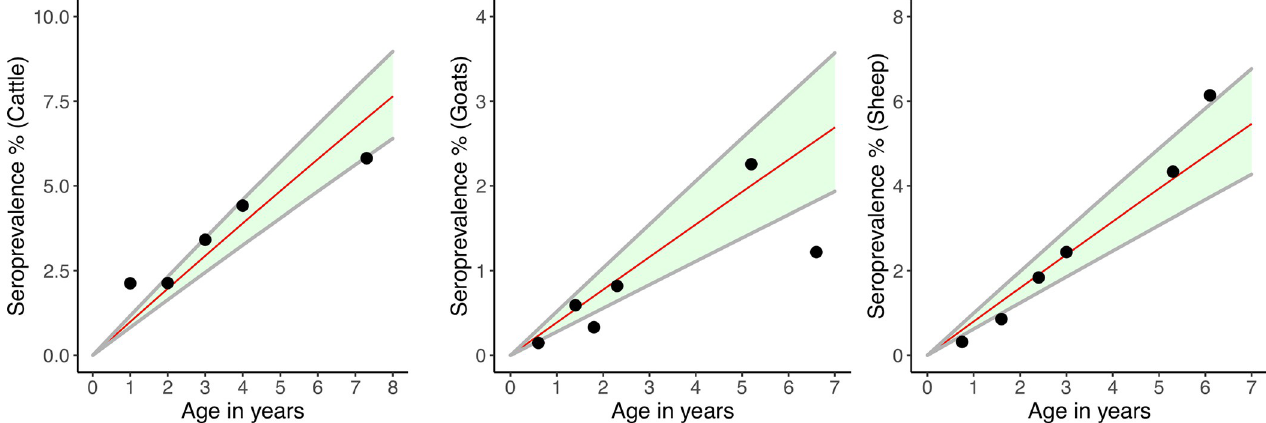
Fig 2. Predicted RVFV seroprevalence (red line) and 95% credible intervals (grey line) by age on the basis of catalytic models for cattle, goats and sheep using data collected in northern Tanzania from 2013 through 2016. Observed seroprevalence by age for each species is overlaid as black circles.